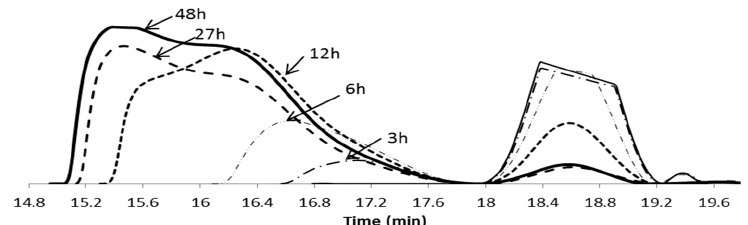
Figure 1. GPC traces from Refractive Index (RI) detector (entry 1 in Table 1) with the final polymer molecular weight of 12.7 kg/mol.